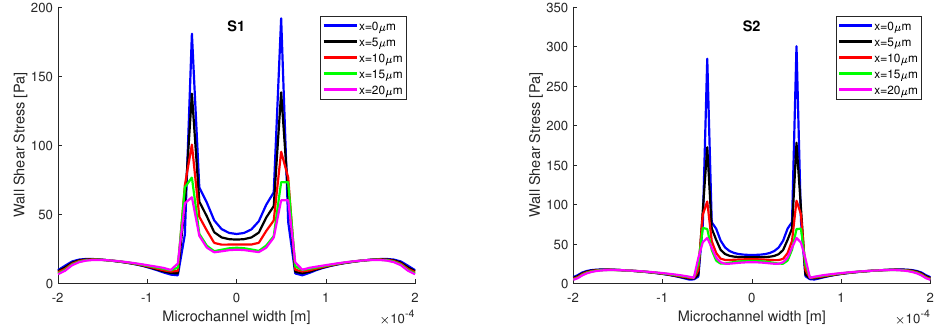
Figure 11. Wall shear stress distribution on 5 lines on the top wall at h = 0 µ